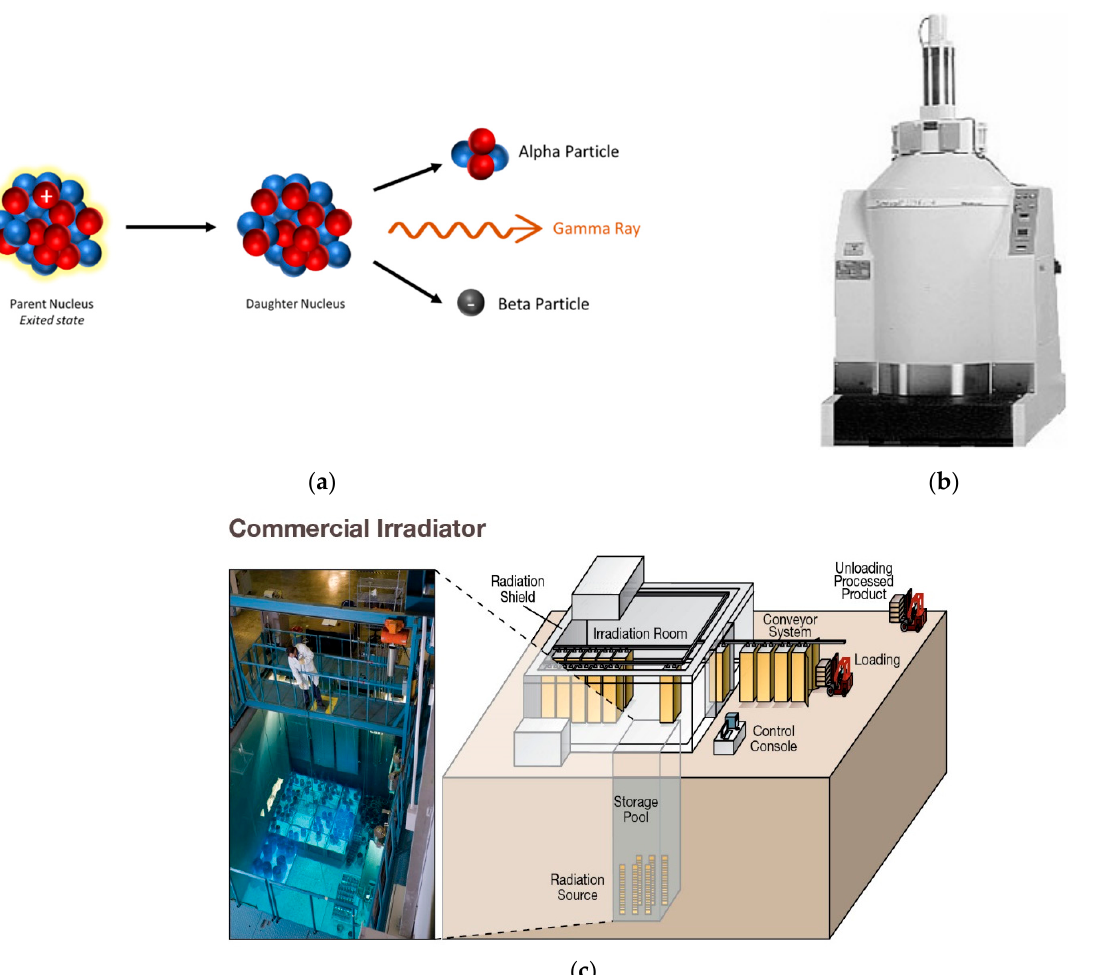
Figure 3. ( a ) Simplified scheme of the gamma ray initiation; ( b ) picture of a GammaCell 220 instrument designed for lab work Nordion™ ; ( c ) scheme of a commercial irradiator designed for industrial scale work Nordion™ .